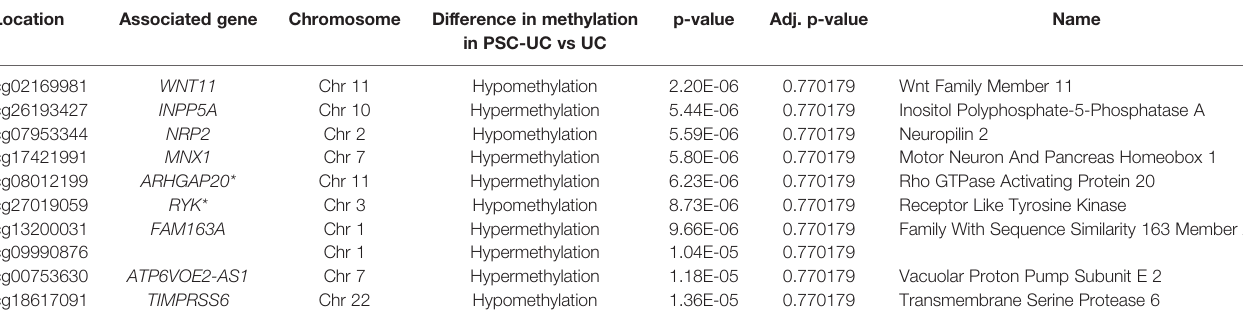
TABLE 2 | Differentially methylated positions (DMPs) when comparing PSC-UC with UC. Location Associated gene Chromosome Difference in methylation in PSC-UC vs